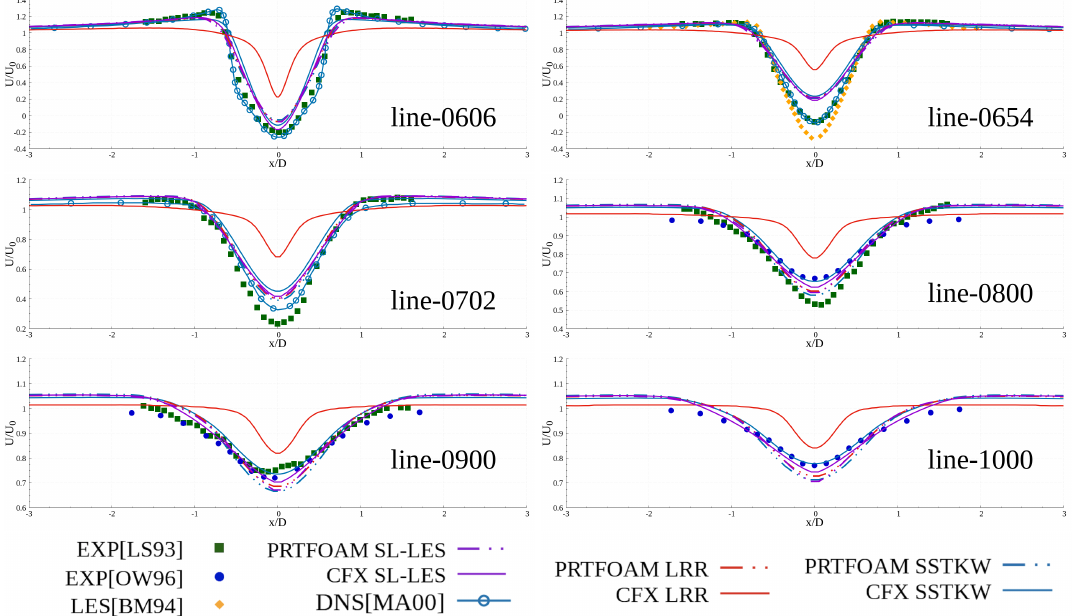
Figure 10. Comparison of mean stream-wise velocity components at the vertical line behind the cylinder including our numerical simulation data, the DNS [17], and experimental data